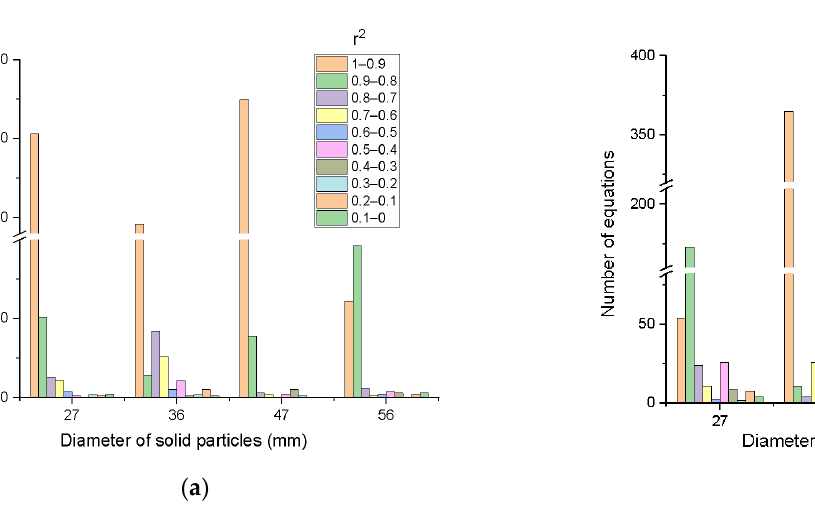
Figure 7. The r 2 coefficient is used to group the equations generated [43]: ( a ) average instantaneous velocity; ( b ) average angular velocity.